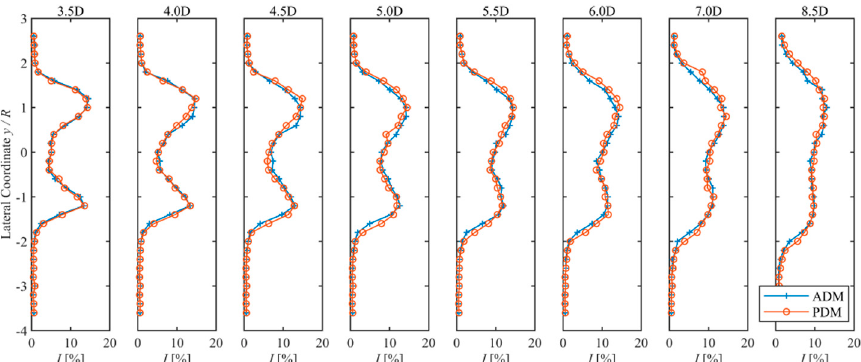
Figure 9. Turbulence intensity distributions in the ADM and PDM at λ = 4 in the UIF wind tunnel.